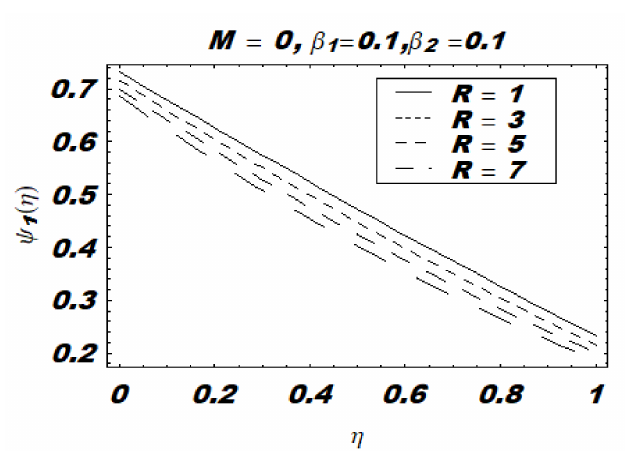
Figure 12. Similarity function ψ 1 for the long